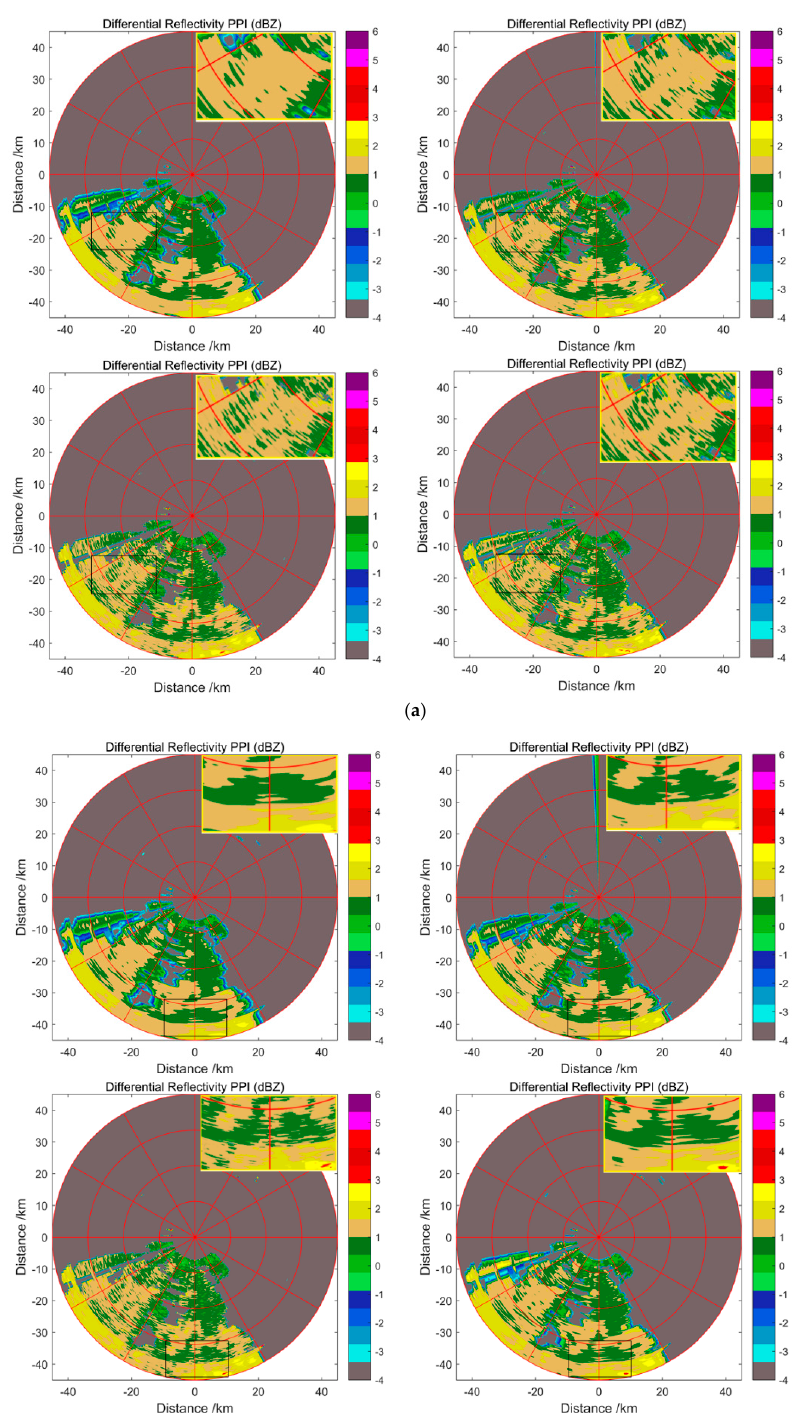
the proposed NSSR algorithm (PSNR = 41.9943; SSIM = 0.9877). ( b ) 4 × reconstruction of reflectivity data. From left to right and top to bottom: bicubic interpolation echo, the reconstructed echo by IBP [13] (PSNR = 32.9533; SSIM = 0.9221), original radar echo, and the reconstructed echo by the proposed NSSR algorithm (PSNR = 37.1748; SSIM = 0.9588). The tested data is the first elevation cut of the XPRAD at 10:43 (BJT) on 28 May 2016.